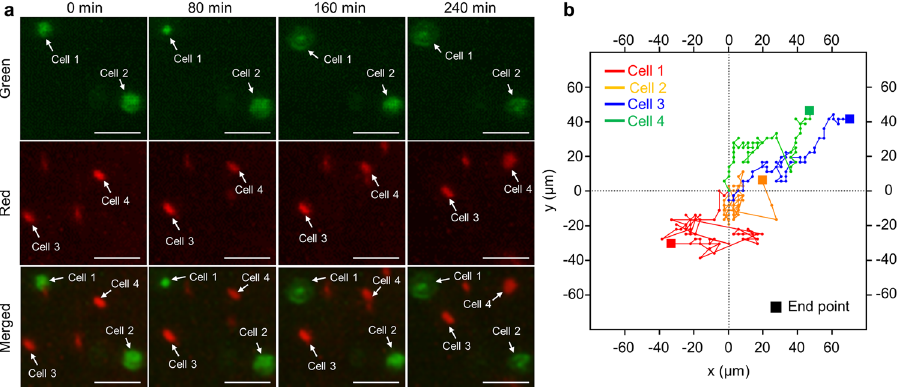
Fig. 6 Real-time monitoring of the green- and red-labeled NIH 3T3 fi broblast cells in an incubator using the miniaturized multicolor fl uorescence imaging system and migration of each labeled cell over time. a Migration of the green- and red-labeled NIH 3T3 fi broblast cells over time. b Change of position of each cell over time. Scale bar: 100 μ m ( a